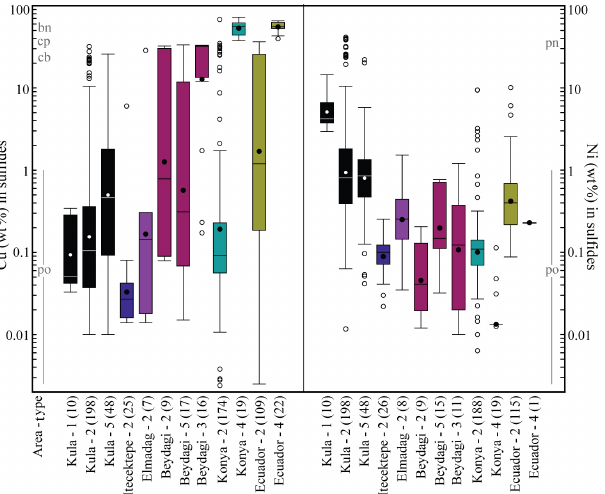
Figure 9. Box plot comparison of the Cu-rich phase (chalcopy- rite = iss) and Ni-rich phase (pyrrhotite ± pentlandite = mss) pro- portions (area%) composing Type 2 sulfides, calculated by Im- ageJ© 1.38 software analysis for each study area ( − N of sulfides reconstructed). Average, mean, and median values are represented in the graph the same as in Fig. 8. For the dataset, see Table 5 at